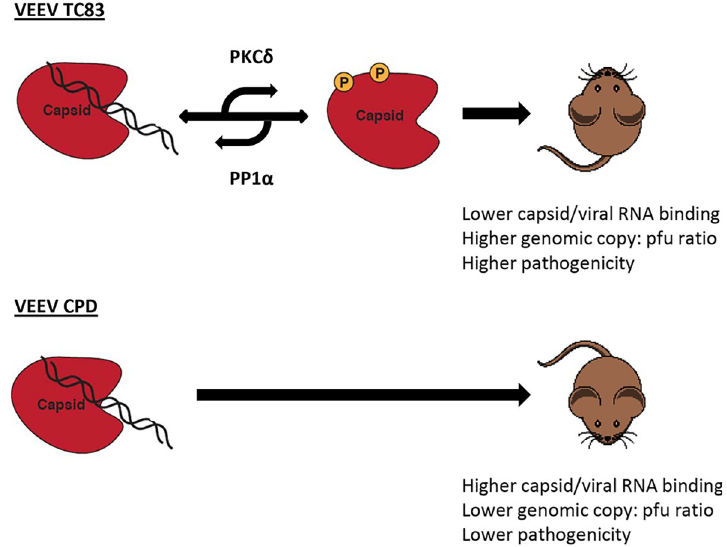
Fig 9. Working model of the capsid phosphorylation and its impact on viral pathogenesis. Our working model is that capsid phosphorylation is a mechanism important for regulating capsid:viral RNA binding. Capsid is dephosphorylated by PP1 α increasing its ability to bind to viral RNA and conversely phosphorylation by PKC δ decreasing viral RNA binding. Capsid phosphorylation regulates VEEV’s genomic copy to pfu ratio and viral